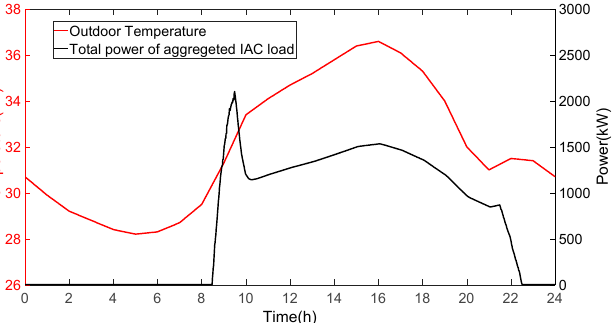
Figure 7. Total power baseline of aggregated IAC load and outdoor temperature.